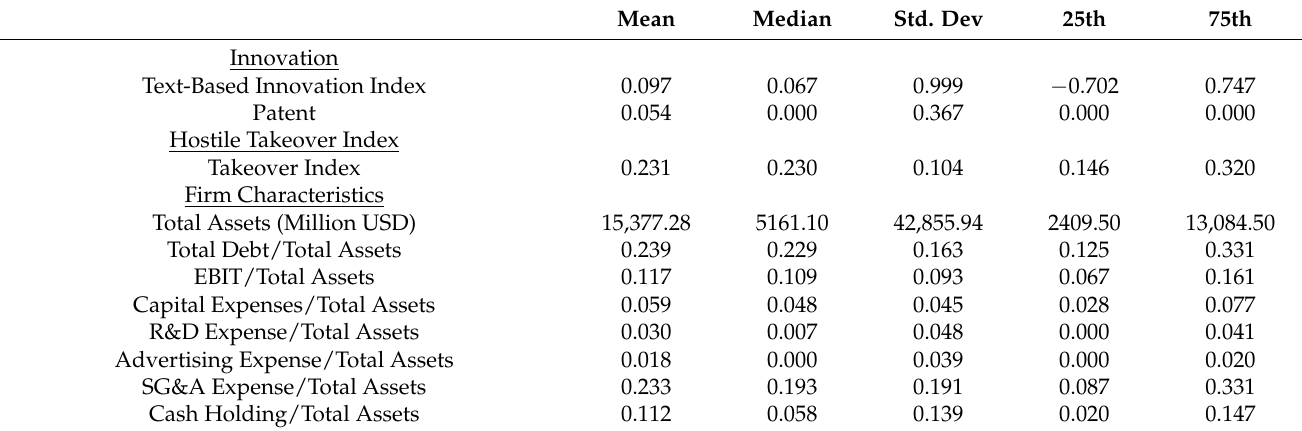
Table 1. Descriptive